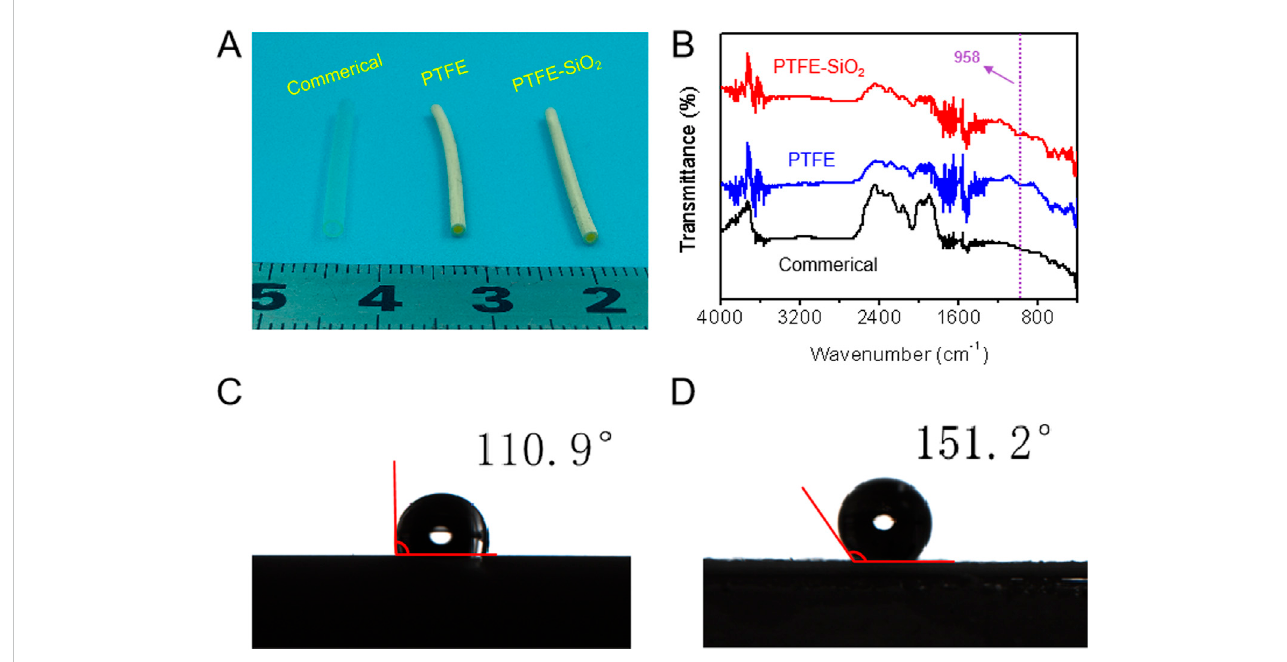
FIGURE 1 (A) The digital photos of commerical catheter, PTFE catheter, and PTFE-SiO catheter, and PTFE-SiO 2 catheter, respectively; (C) and (D) Water contact angle of the lumen surface of the inner surfaces of PTFE catheter, and PTFE-SiO 2 catheter at the 5 s time point,